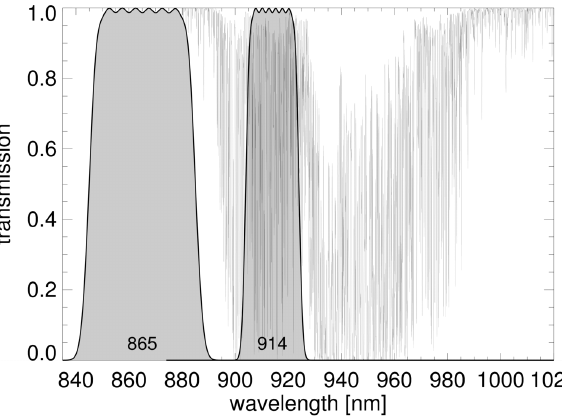
Fig. 3. MTG-FCI original channel constellation in the NIR (normal- ized response functions) and total transmittance of the atmosphere in ρστ -band.